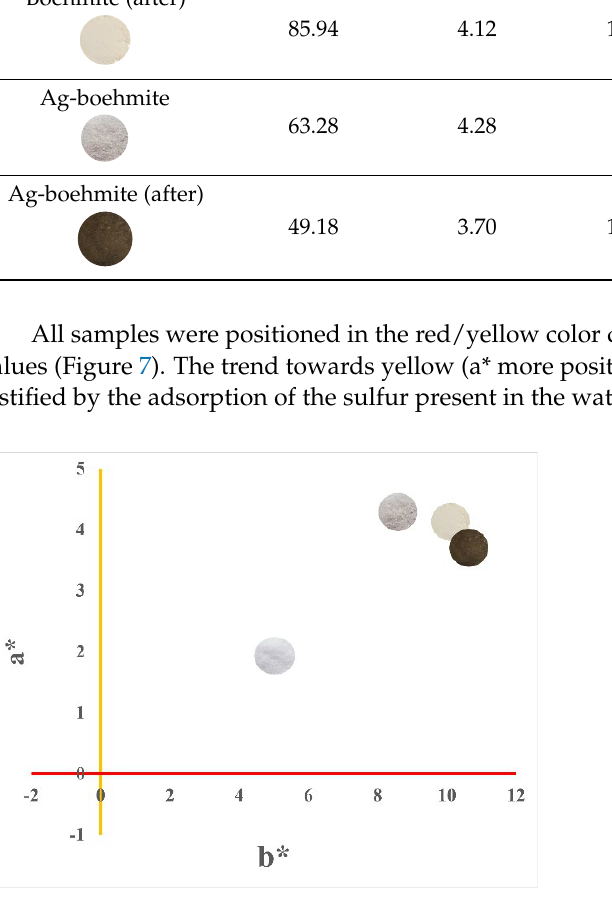
Figure 7. Graph of colorimetric parameters +a* (yellow) vs. +b* (red). Colorimetric measurements (L*a*b*) were performed on the respective samples in the form of powder.